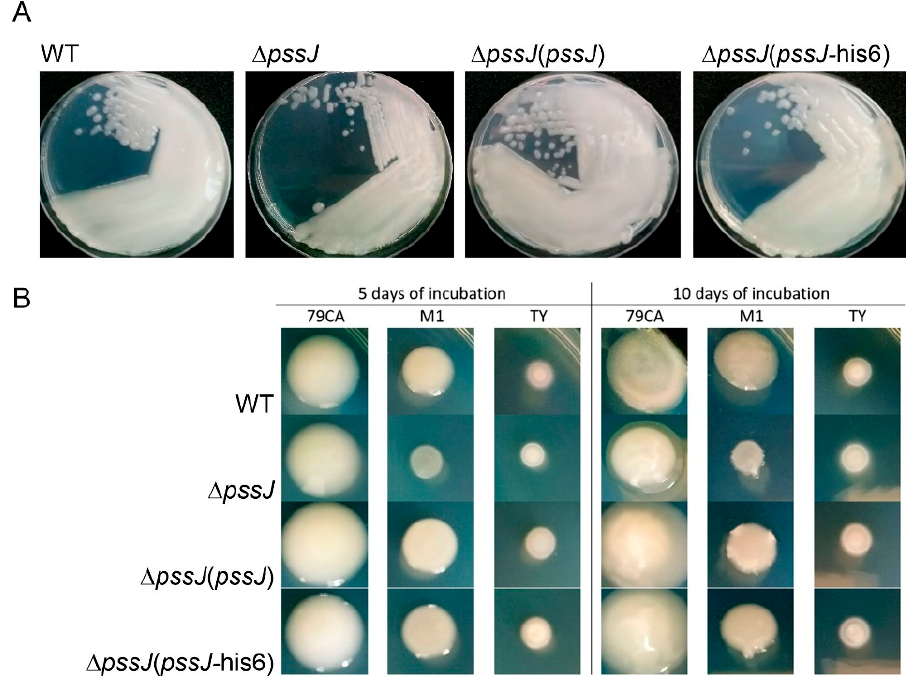
Figure 4. Single colony morphology ( A ) and growth / polysaccharide secretion ( B ) of the wild type strain and its derivatives: ∆ pssJ , ∆ pssJ ( pssJ ), and ∆ pssJ ( pssJ -his6) during cultivation in solid 79CA, M1, and TY media. Bacterial suspensions in the bottom panel were washed and standardized to the same starting optical density. Photographs were taken 5 and 10 days post-inoculation (left and right, respectively). The ∆ pssJ mutant produced significantly less exopolysaccharide than the wild type (88.7 ± 0.6 vs. 100.6 ± 8.6 µ g EPS / mg of bacterial pellet) (Figure 5A). The amount of total EPS produced was